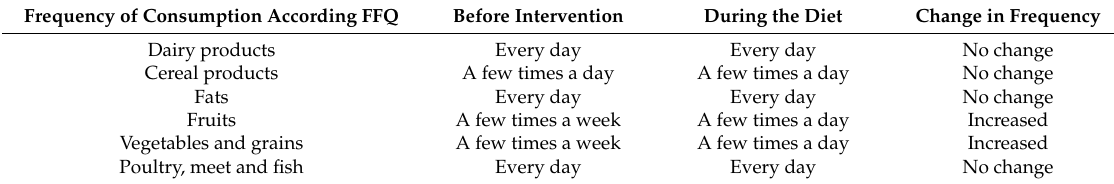
Table 4. Changes in patients dietary patterns during the intervention.